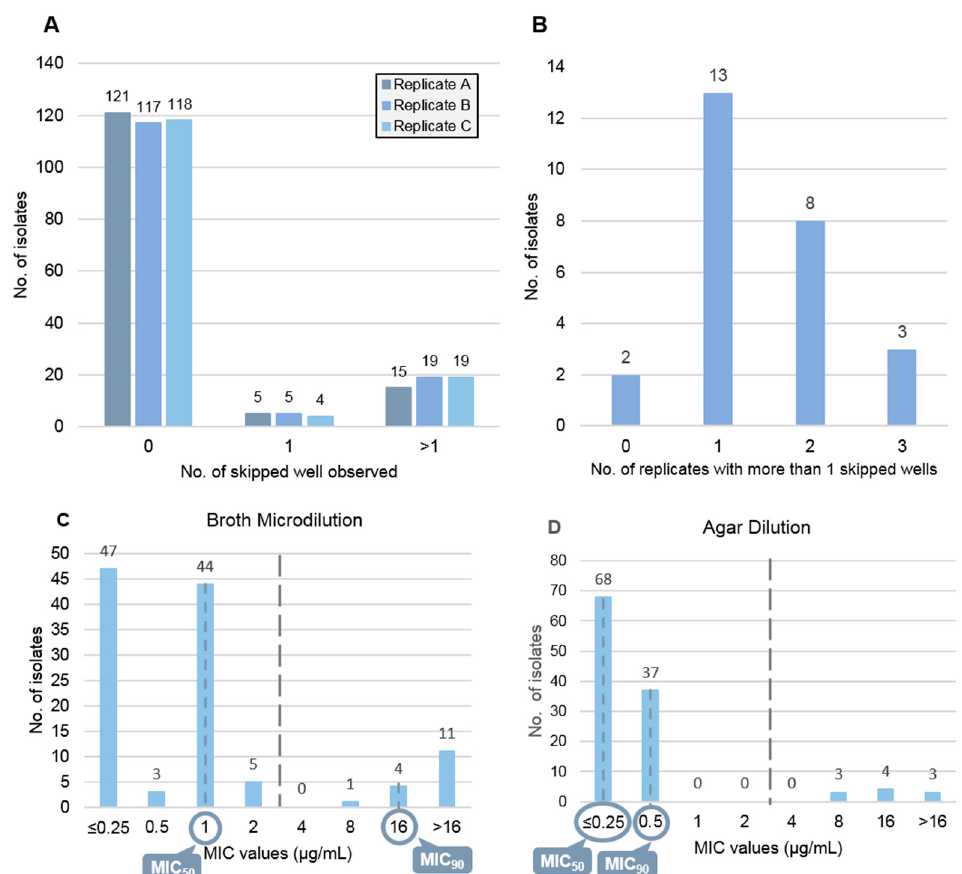
Figure 1. Results obtained for colistin susceptibility testing by BMD (reference method) and AD. ( A ) Number of isolates with 0, 1 or more than 1 SW in each of the three replicates tested ( A – C ) by BMD. ( B ) Distribution of isolates with undetermined MIC ( n = 26) by the number of replicates showing more than one SWs: all replicates ( n = 3), 2, 1 or none ( n = 0). MIC distribution obtained by ( C ) broth microdilution and ( D ) agar dilution, MIC 50 and MIC 90 values are highlighted for each method.